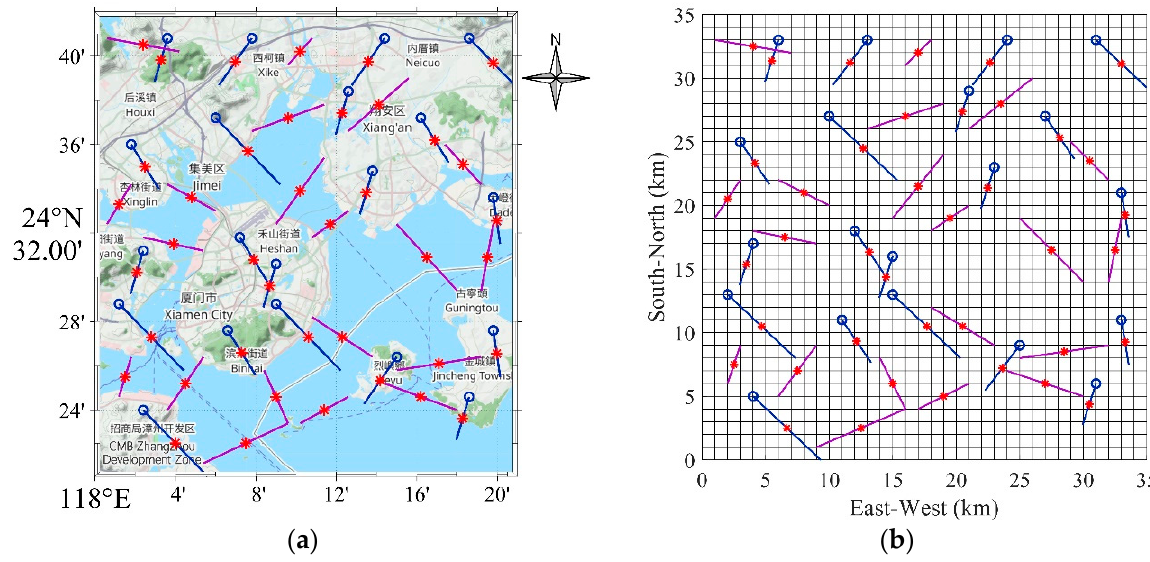
Figure 5. Network distribution of ESLs and HMLs in Xiamen: ( a ) Distribution of the original link network; ( b ) Distribution of the link network in the gridded area. The blue lines represent the ESLs, the blue markers “o” indicate the location of the satellite antennas, the purple lines represent the HMLs, and the red markers “*” indicate the midpoint of the